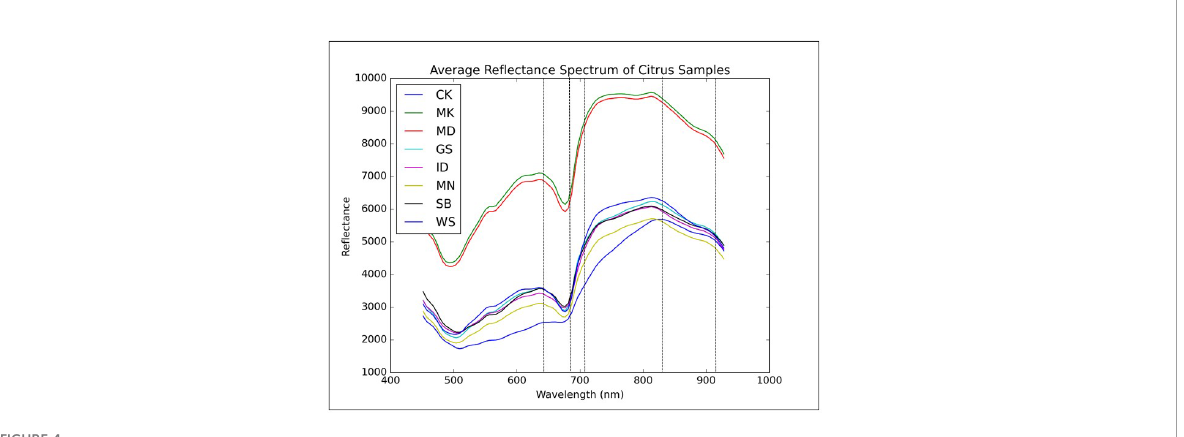
FIGURE 4 Mean re fl ectance spectra of grapefruits with eight different peel conditions. Dashed lines represent fi ve wavelengths (666.15, 697.54, 702.77, 849.24 and 917.25 nm) selected by principal components analysis.